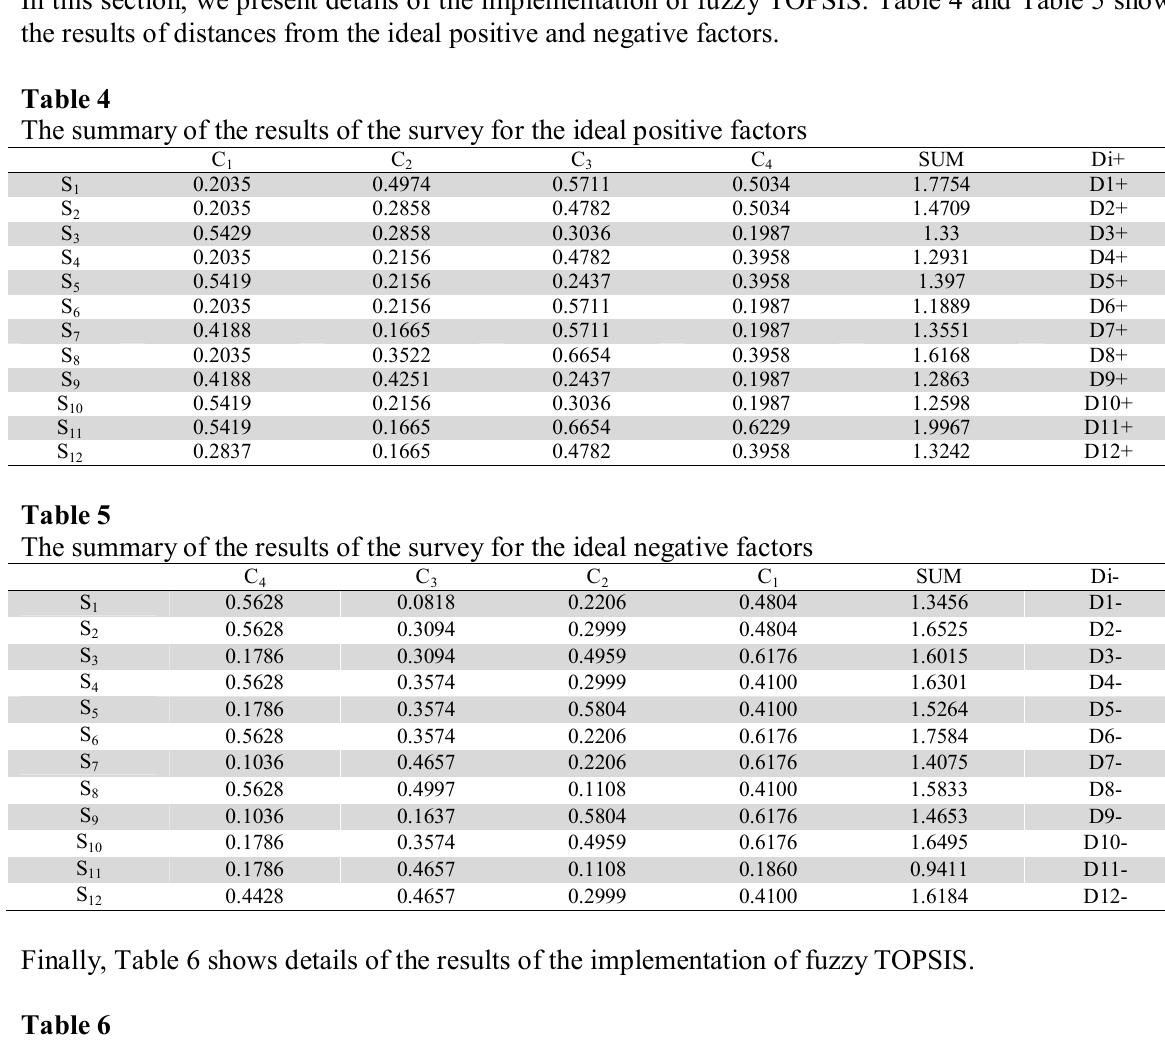
The summary of ranking based on fuzzy